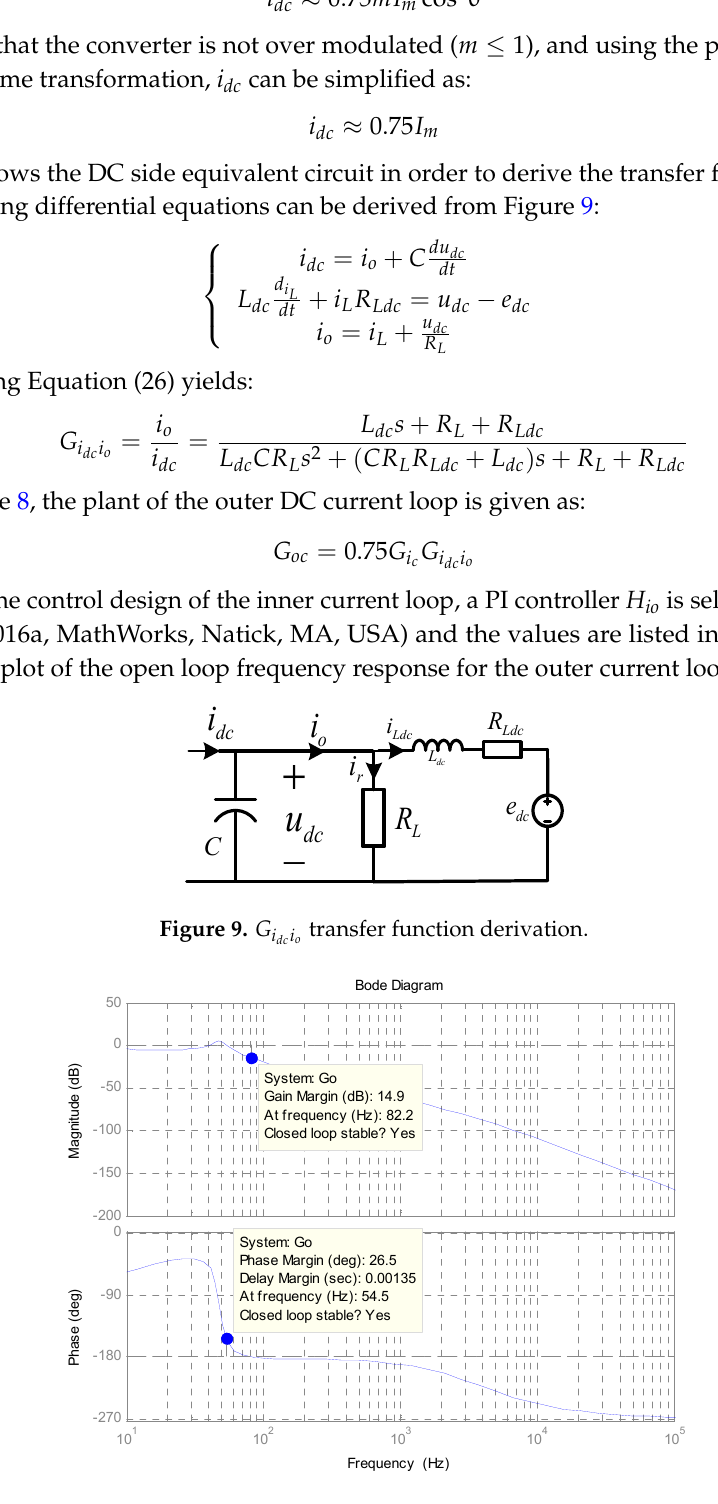
Figure 10. Bode plot of the open loop frequency response for the outer current loop.